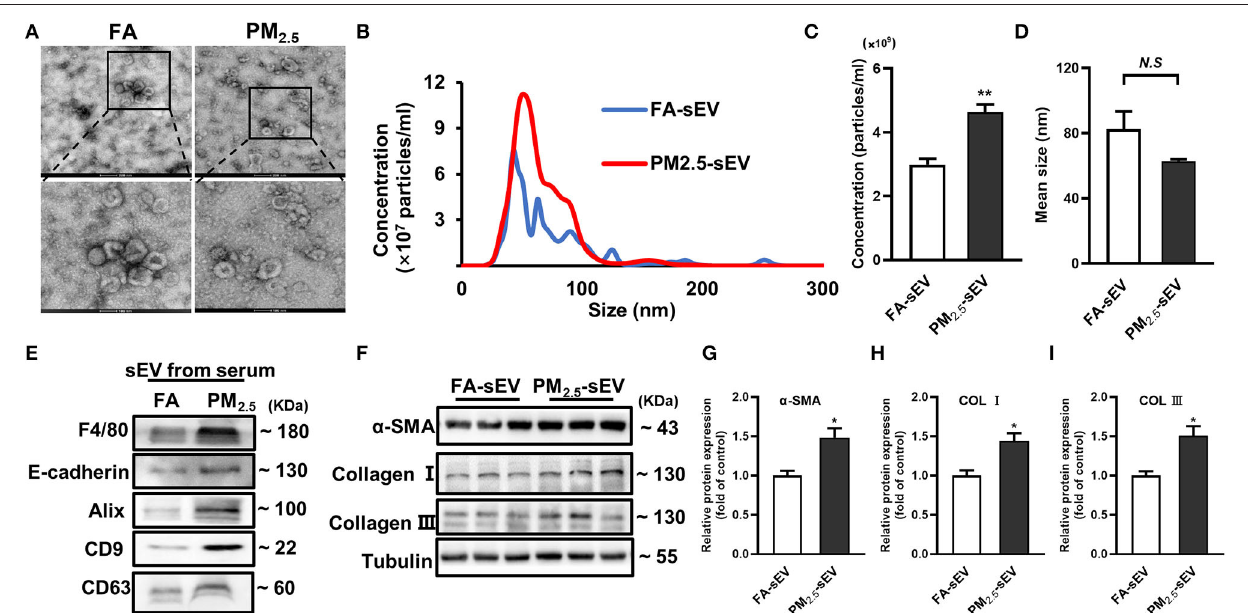
FIGURE 2 | Serum sEV from PM 2.5 -exposed mice increased the level of fibrosis-related proteins in cardiomyocytes. (A) Representative TEM images of isolated serum sEV, scale bars: 500nm, 100nm. (B) Representative results of NTA demonstrated the concentration and distribution in FA-sEV and PM 2.5 -sEV. (C) The average concentration in FA-sEV and PM 2.5 -sEV. (D) Mean size in FA-sEV and PM 2.5 -sEV. (E) Representative images of Western blot in macrophage marker (F4/80), epithelial cell marker (E-cadherin), and sEV marker (Alix, CD9, and CD63) in FA-sEV and PM 2.5 -sEV. (F–I) Relative protein expressions of α -SMA, Col I, and Col III in HL-1 cells treated with sEV analyzed by Western blot ( n = 4). All the data were presented as mean ± SEM ( t -test), n = 5, *indicates p < 0.05, **indicates p < 0.01. N.S indicates no